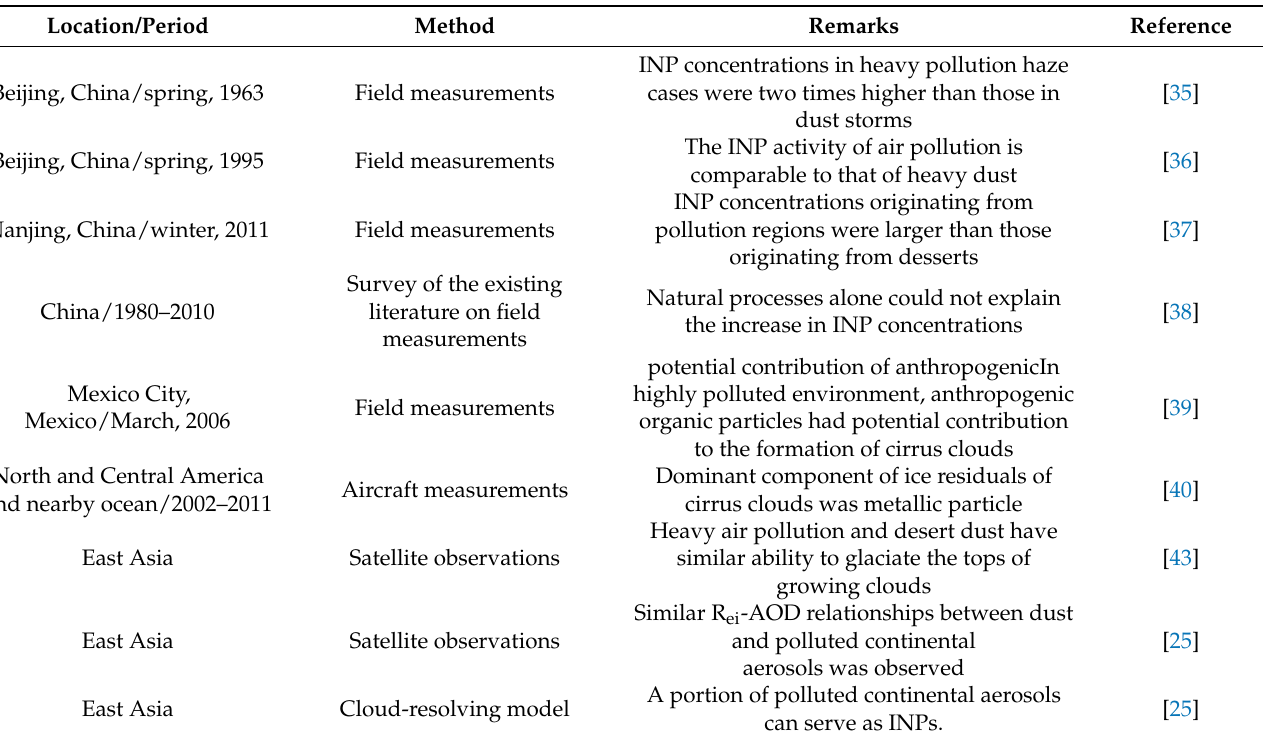
Table 1. Summary of investigations on the ability of anthropogenic aerosols serving as